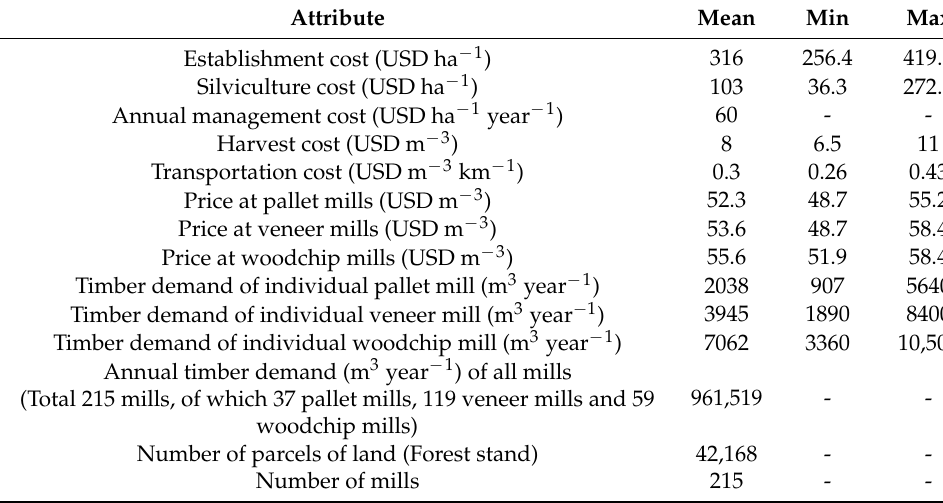
Table 3. The value of attributes used for the optimization model.